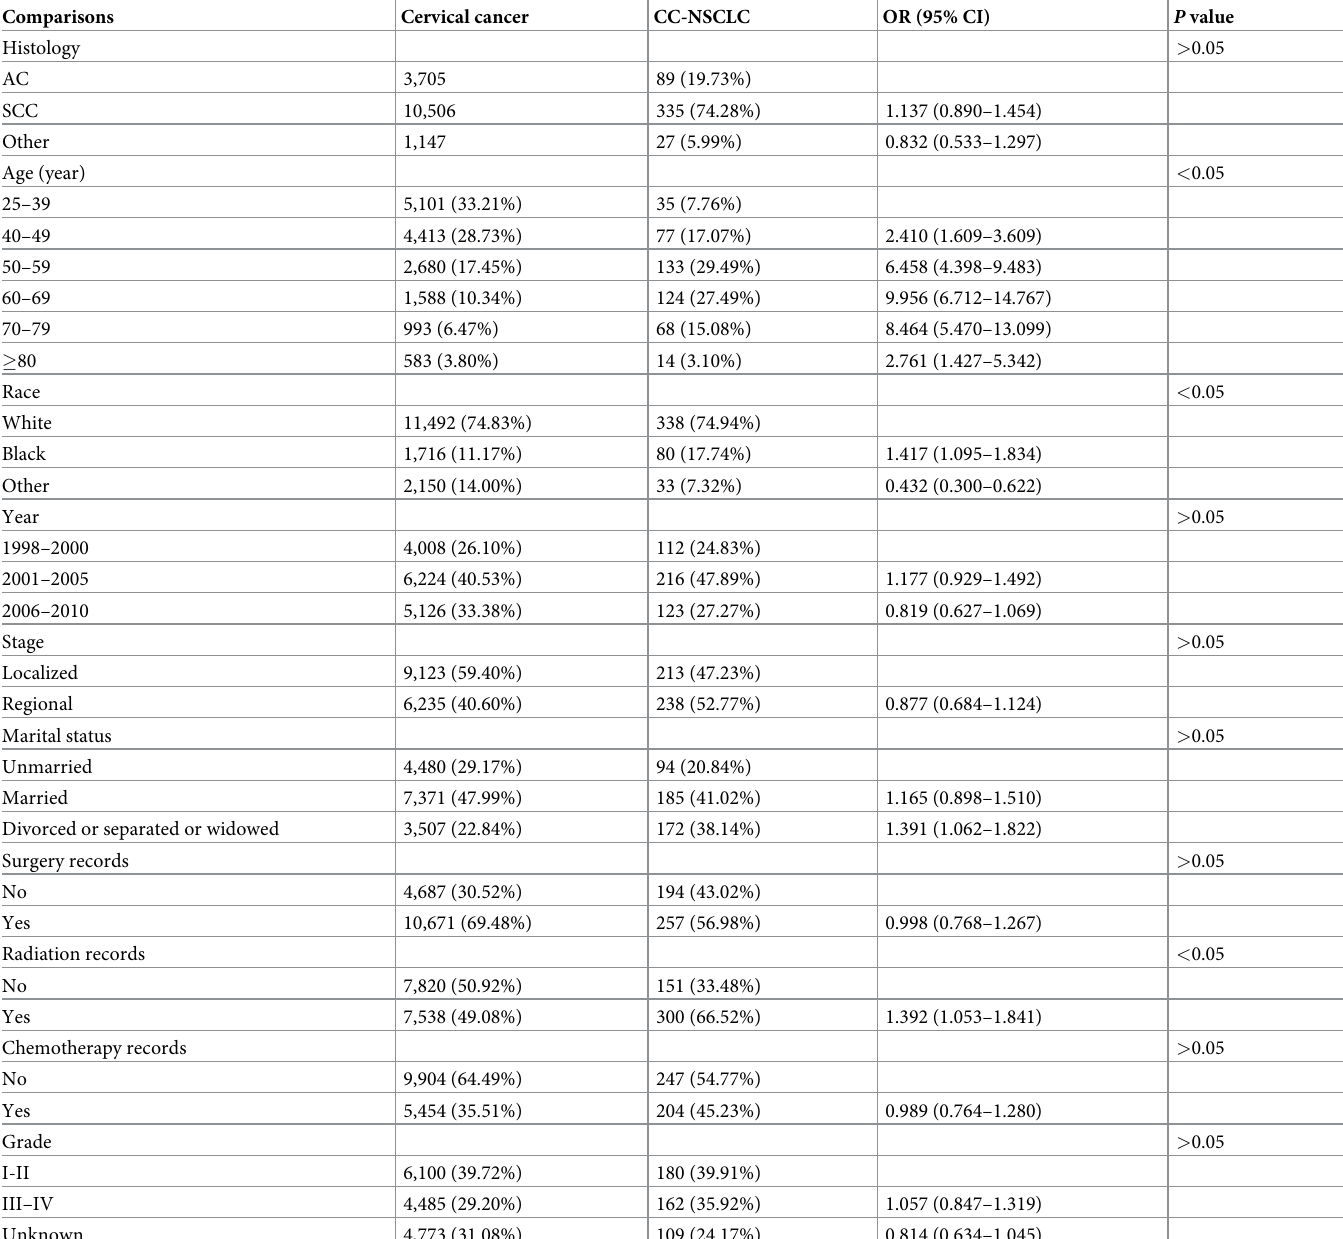
Table 4. Risk factors for second primary lung cancer in patients with cervical